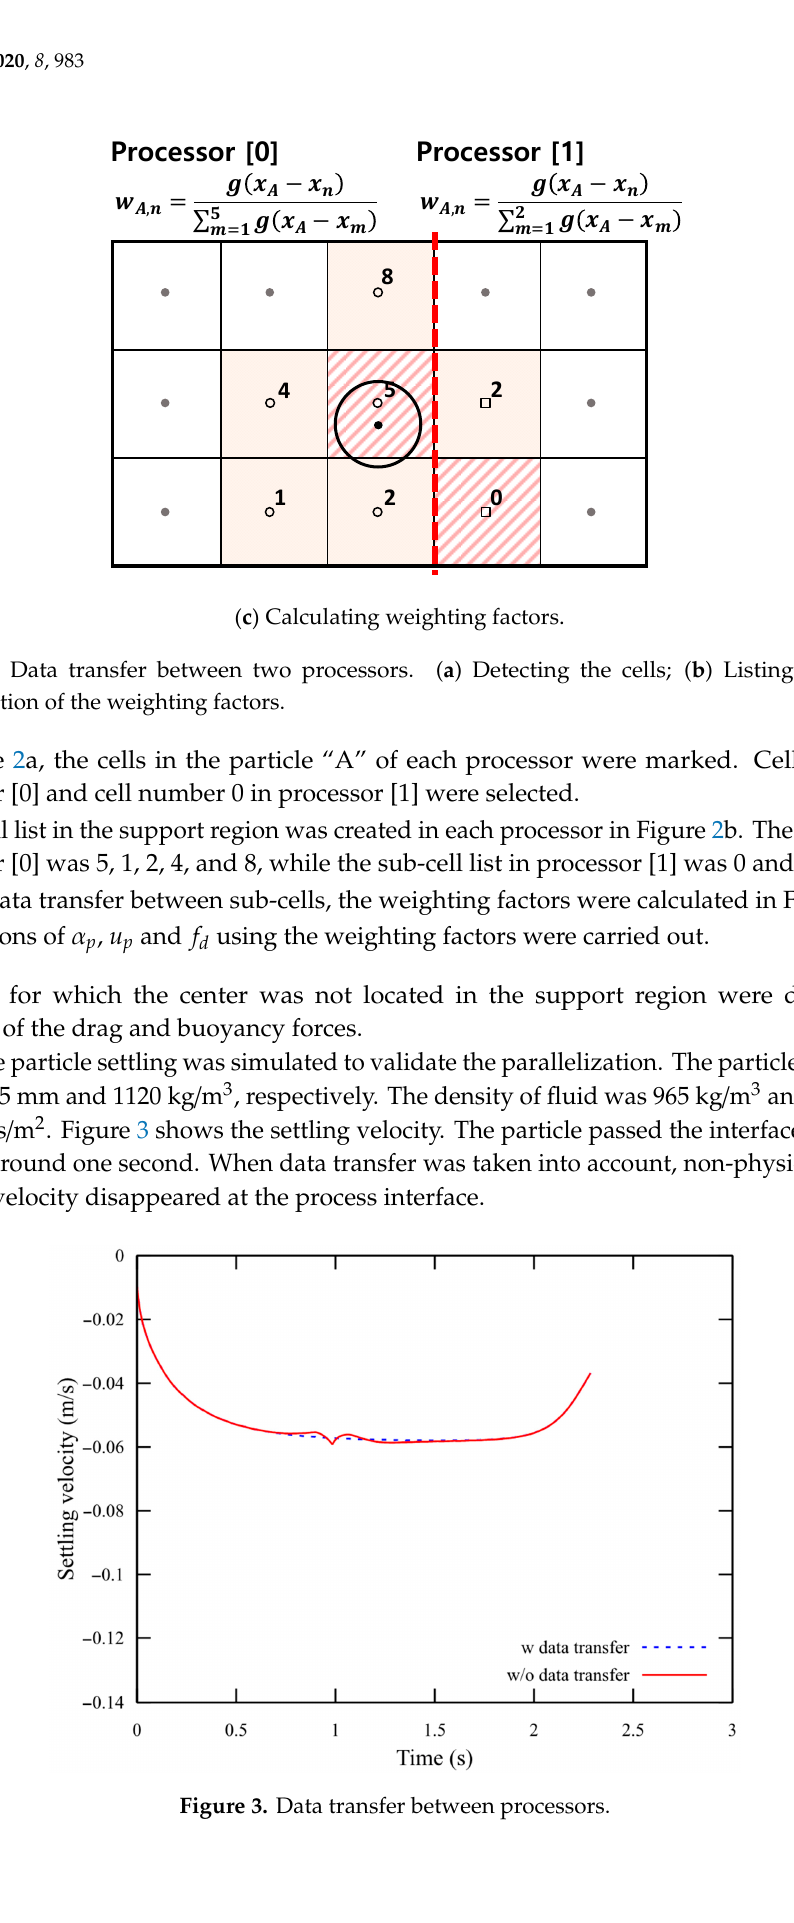
Figure 3. Data transfer between